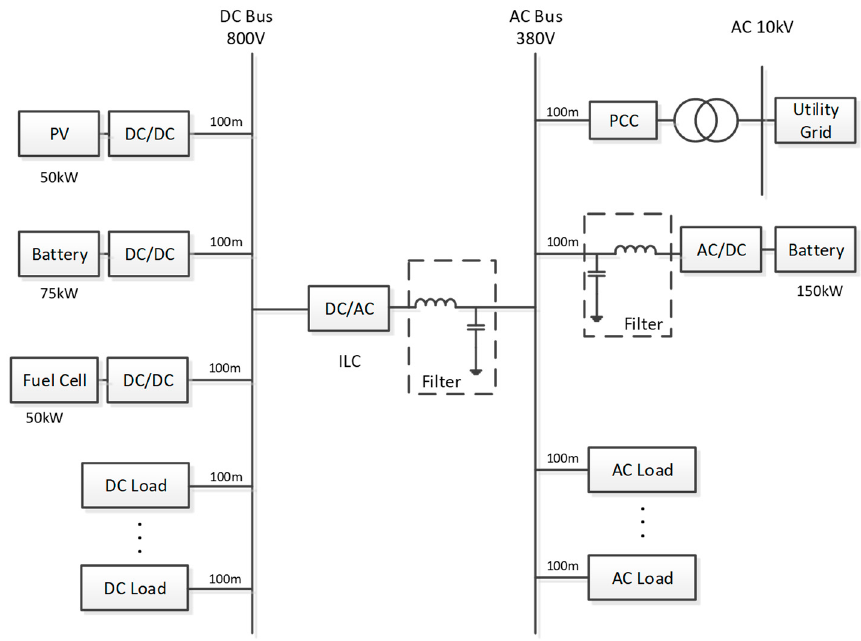
Figure 1. Hybrid micro-grid structure of a small plant.